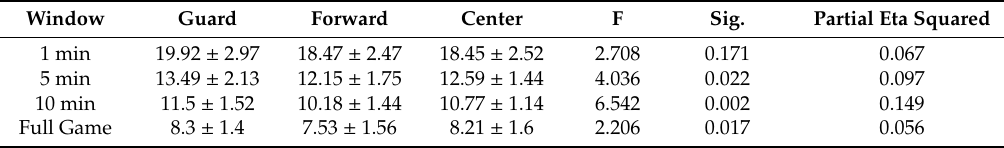
Table 2. The descriptive analysis (mean ± SD) of different time windows for different playing positions. Window Guard Forward Center Sig.